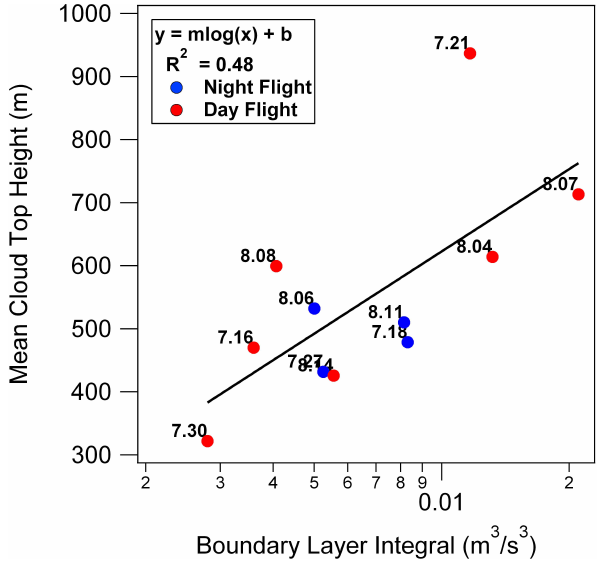
Fig. 8. Scatter plot of the entrainment efficiency η versus the en- trainment integral (i.e. R − F b from Eq. 6). Each point is the average value for the flight, with the corresponding date beside each point, and color denoting day and night